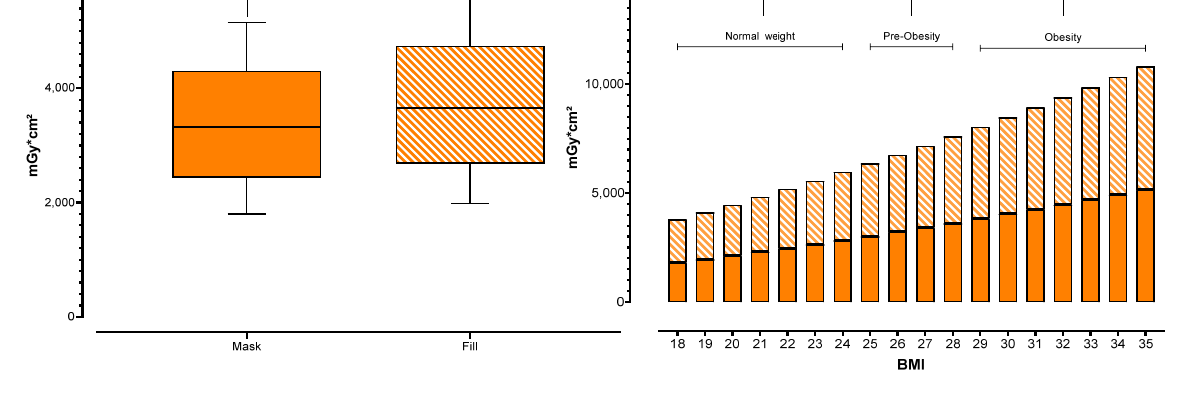
Figure 2. Radiation Exposure. Table 2. Objective image quality